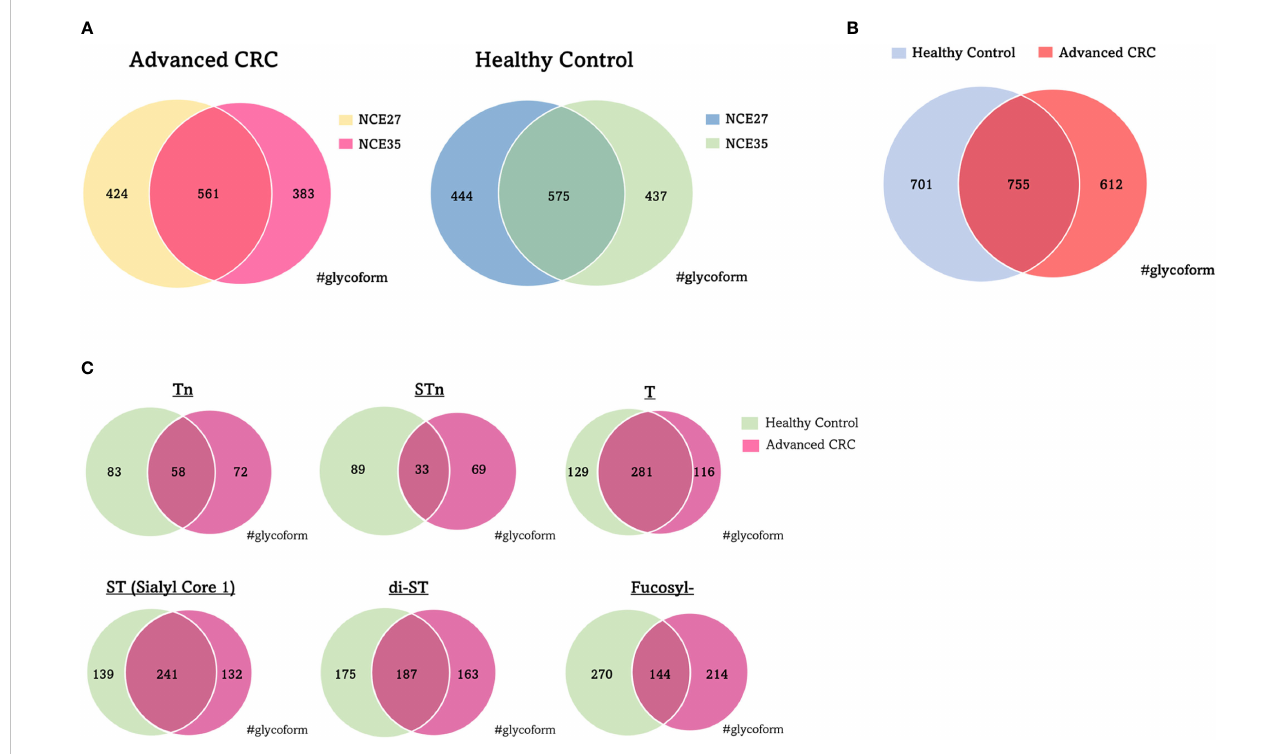
FIGURE 2 Qualitative comparison of O-glycoforms identi fi ed by LC/MS/MS. (A) Venn diagrams of O-glycoforms with different NCE. (B) Venn diagram of O- glycoforms identi fi ed in serum with advanced CRC patients and healthy individuals. (C) Venn diagram showing the distribution of typical O-glycoforms identi fi ed in serum with advanced CRC patients and healthy individuals. NCE, normalized collision energy; CRC, colorectal